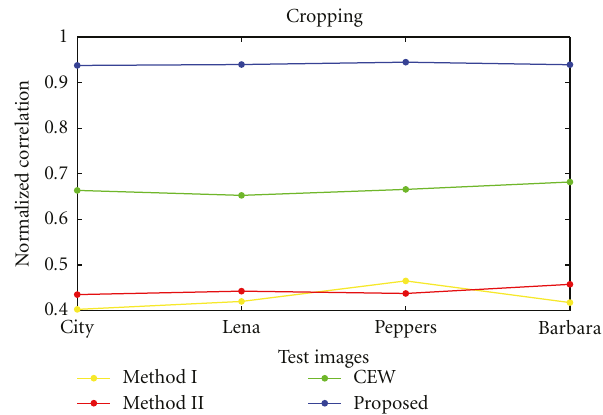
Figure 18: The robustness comparison result of the proposed method with [2, 3] under cropping attack (400 × 450).